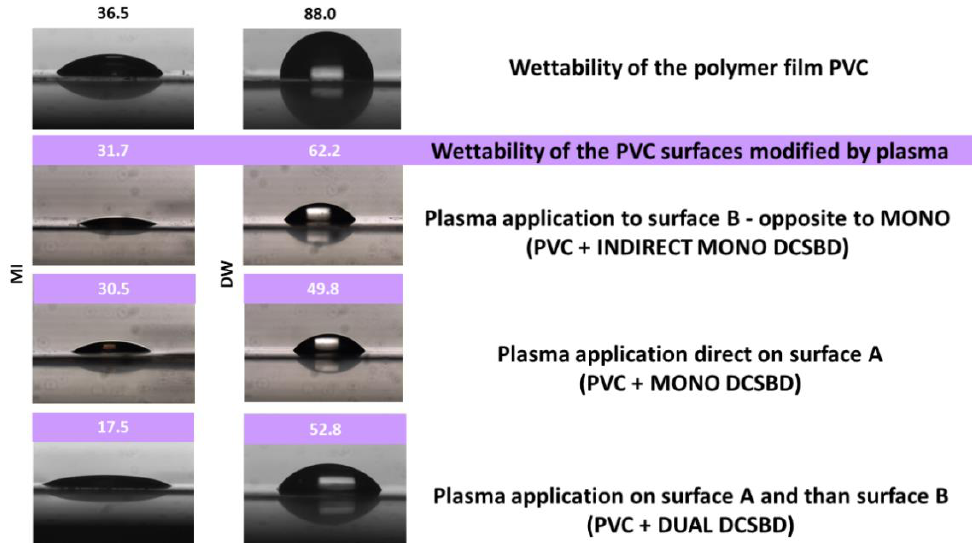
Figure 4 . Wettability of PVC surfaces (unmodified/modified by plasma: Type 1/Type 2). Figure 4. Wettability of PVC surfaces (unmodified/modified by plasma: Type 1/Type